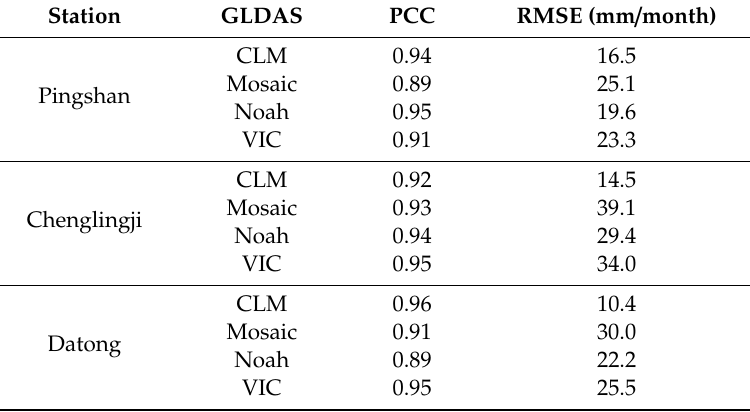
Table 4. Statistical comparison between remotely sensed MODIS evapotranspiration and the GLDAS modeled evapotranspiration data at the three selected stations along the upper, middle, and lower reaches of the Yangtze River basin. Station GLDAS PCC RMSE (mm /